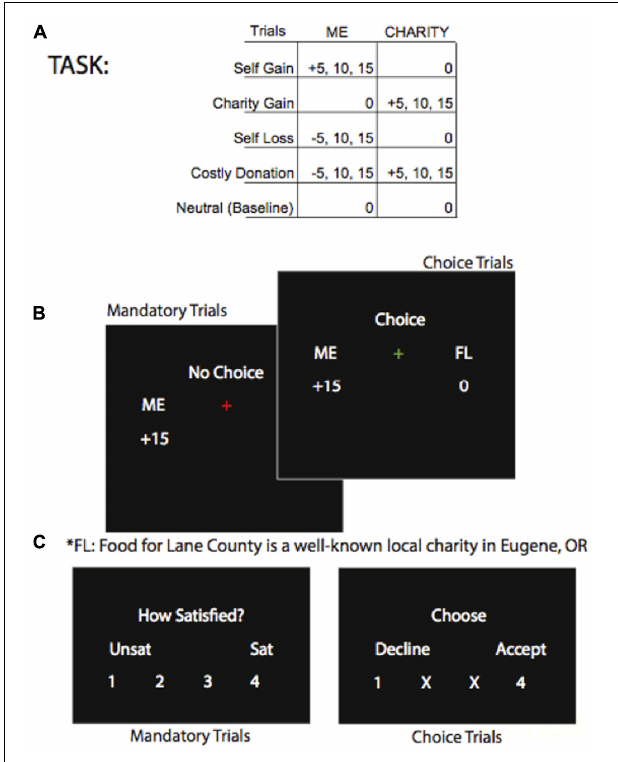
FIGURE 1 | ( A , top panel) Shows the possible trial types. ( B , mid panel) Shows the screens for mandatory and voluntary trials showing an example of a “Self-Gain” trial type of $15 transferred to the participant and $0 transferred to the charity. ( C , lower panel) Shows the rating screen for mandatory transfers and the rating screen for voluntary